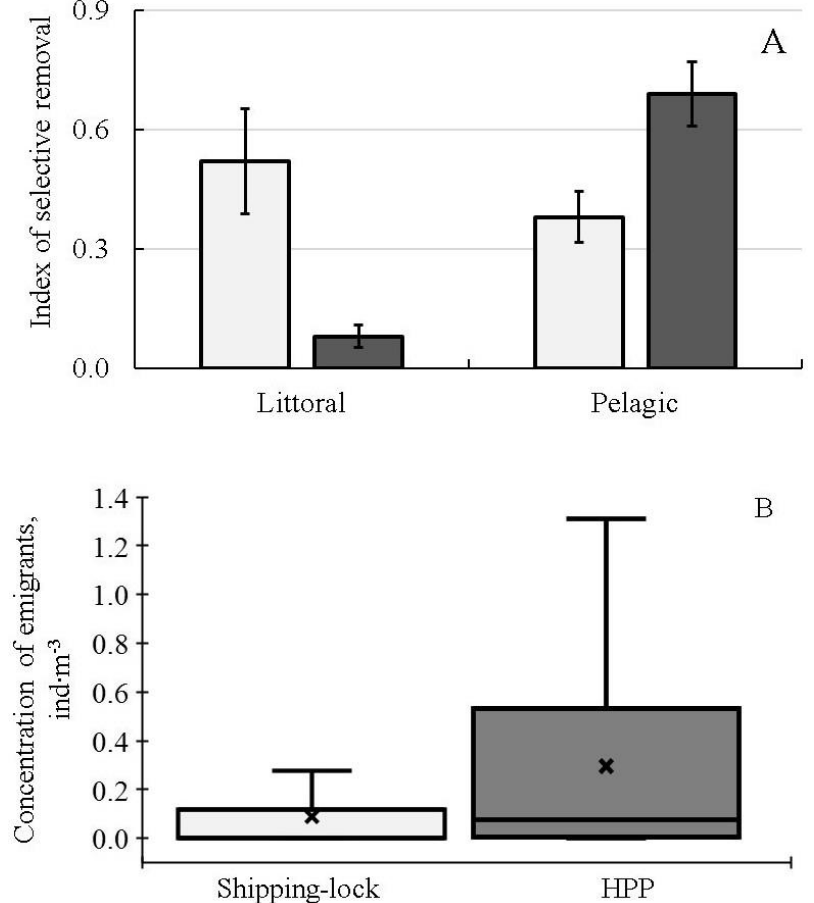
Figure 3. Fish emigration from the Sheksninskaya Reservoir through the two types of water intakes: deep-water intake of the Sheksninskaya HPP, and Shipping-lock located in the same dam closer to the shore. ( A )—Selective removal, SR-index, of littoral and pelagic inhabitants through the water intakes of the HPP (dark bar) and Shipping-lock (light bar). Mean values and standard errors are shown. Observed differences for the ecological groups of fishes are significant (Kruskal–Wallis H test: H 4,24 = 13.3; p = 0.004). ( B )—concentration of emigrants through the HPP and Shipping-lock. Medians (x) with the box-and-whisker plot. Differences are significant according to Wilcoxon signed-rank test: Z 19 = 3.82, p = 0.00013. Number of sampled fish: migrants through the HPP water intake—27,500 ind., through the Shipping-lock—7500 ind. Data from [37]. See Table S5 for more details.